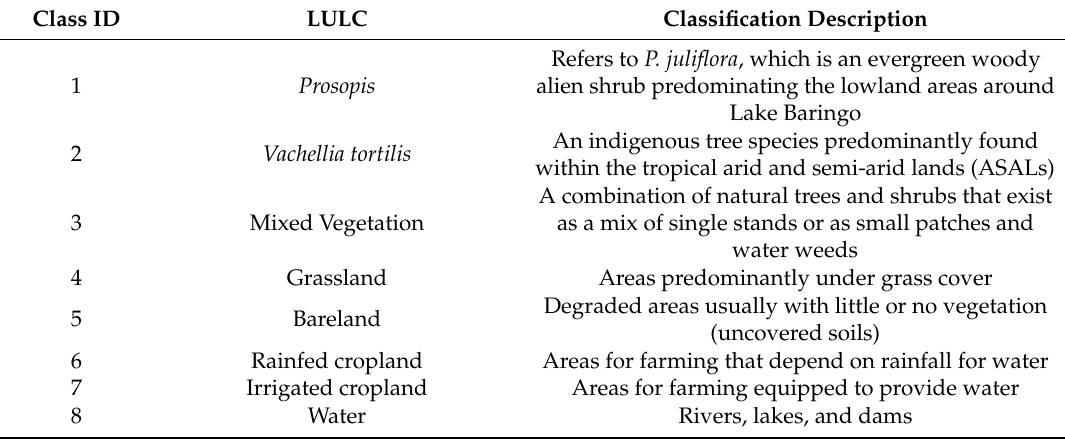
Table 1. Land-use and land-cover (LULC) classes present in the study